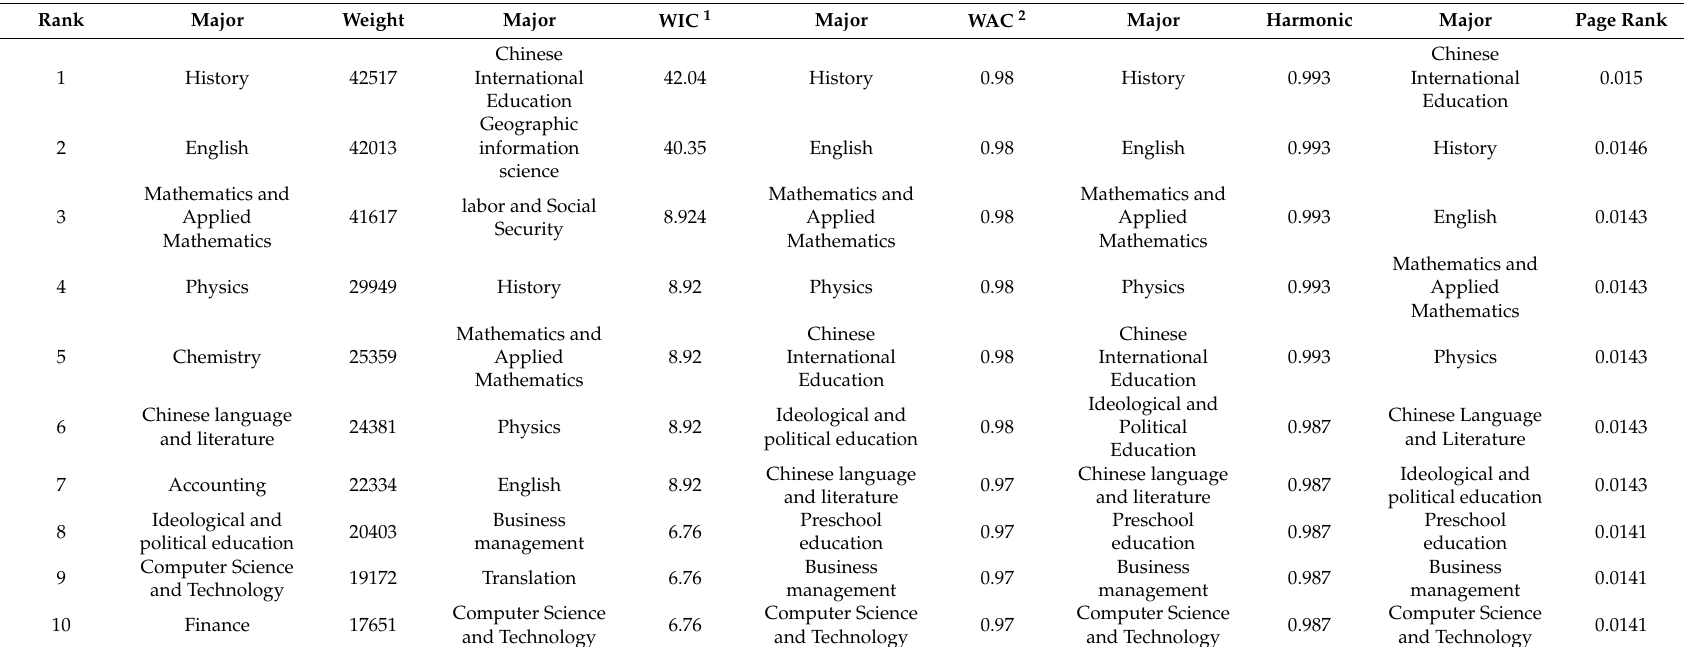
Table 6. Ranking results of indicators (top